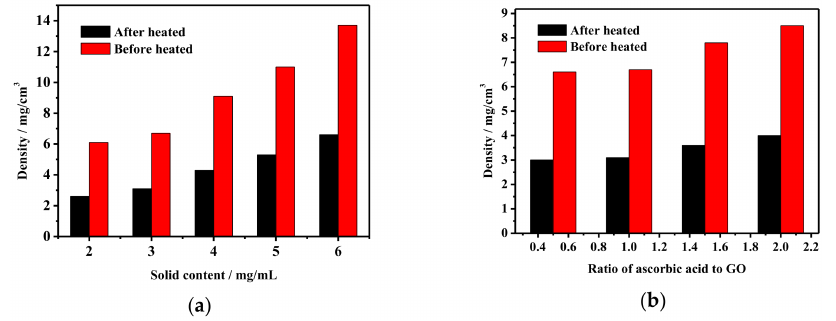
Figure 2. The density of aerogels: ( a ) Aerogel density before and after heat treatment; ( b ) Aerogel density under different ascorbic acid